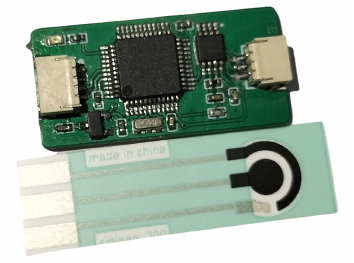
Figure 2. Three-electrode potentiostat and SPE